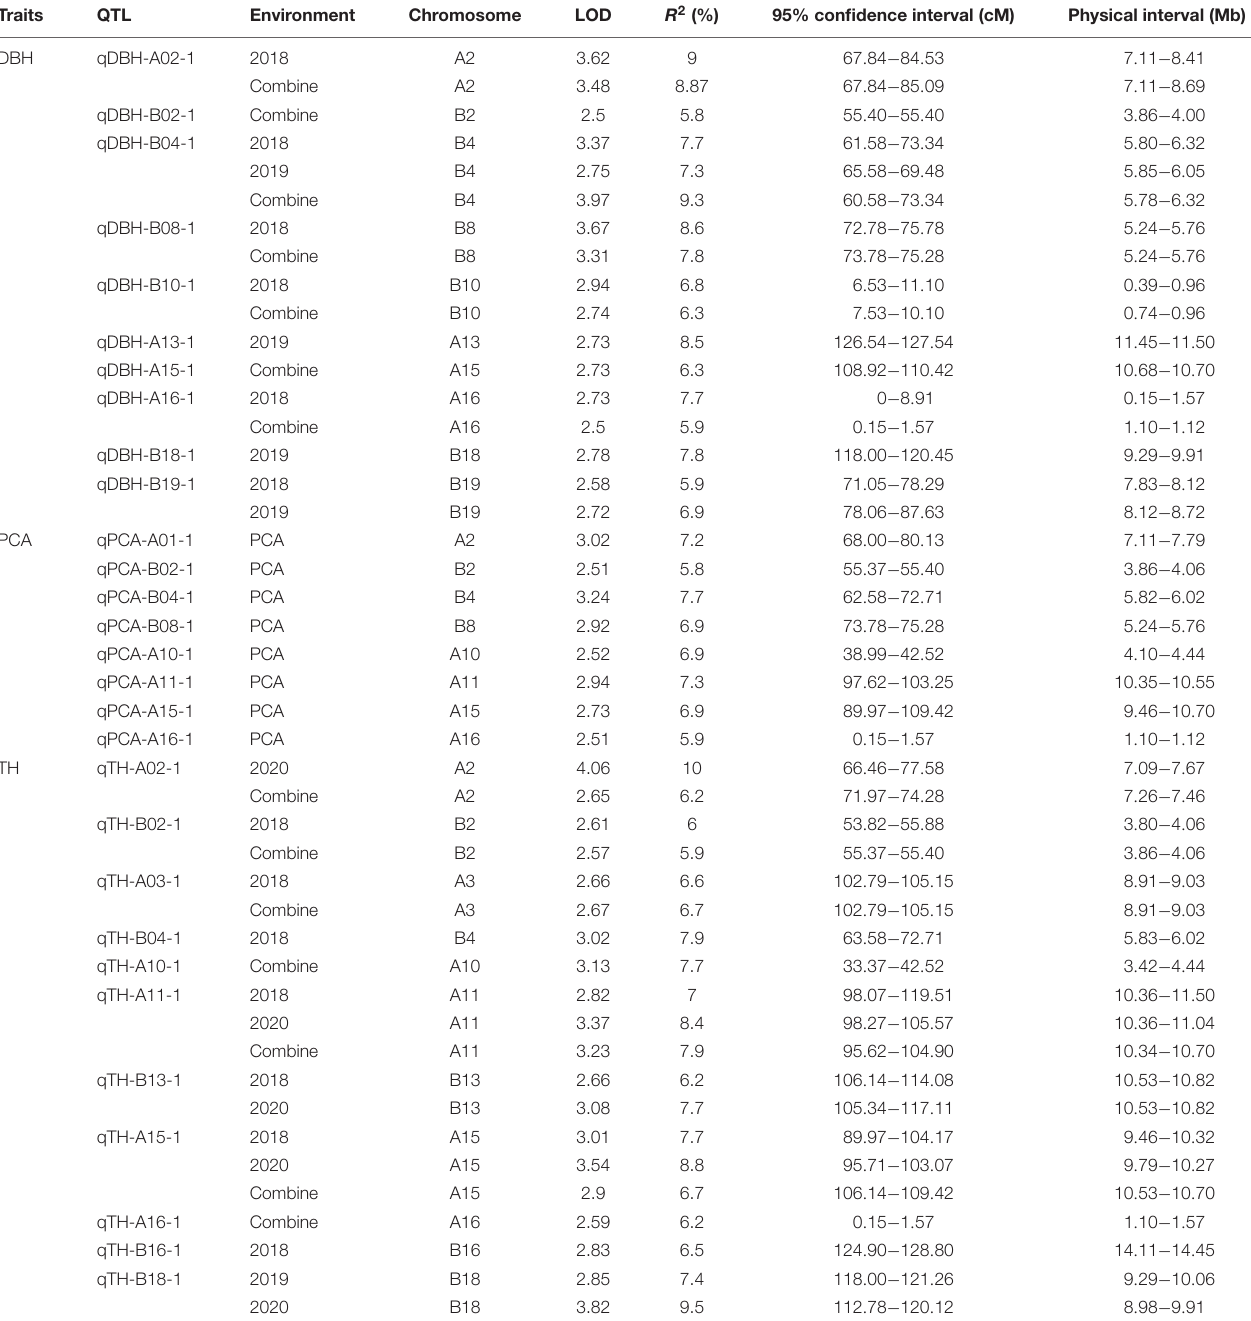
TABLE 3 | Detailed information of 29 QTL for fast-growing in F 1 population.